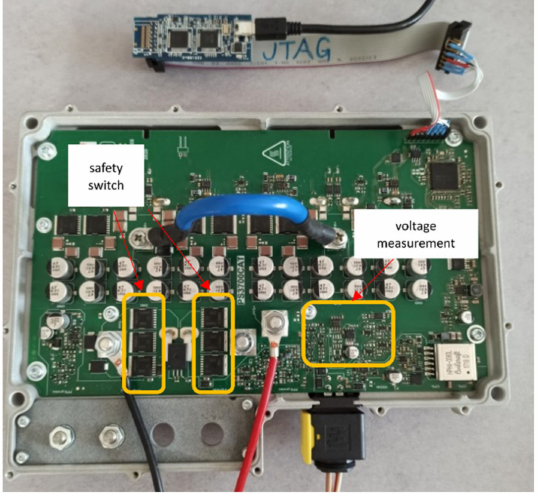
Figure 15. DC/DC converter prototype fitted with single-stage conditioning circuits. In Figure 16, experimental results for voltage error (labelled deltaU) on the full-scale range of measured input voltages from 0 V to U FS , ag = 3.3 V and 0 V to U FS , HP = 60 V are displayed for original (labelled u ag and u HP ) and reversed polarity labelled ( u ag , R and u HP , R ) for u gG = 0 V. Next, both circuits were exposed to a changing negative CMV ( u gG ) from 0 V to − 60 V, while preserving the measured voltages at their full-scale values of U FS , ag = 3.3 V and U FS , HP = 60 V. As expected from Figure 8, the circuit output voltage should remain constant (i.e., at 3.3 V) irrespective of the applied negative CMV, however, this is not entirely true as seen from Figure 17. Otherwise, if the difference amplifier circuit is not well balanced (i.e., R 1 (cid:54) = R 3 and/or R 2 (cid:54) = R 4 ), we could expect a significant discrepancy compared to balanced (ideal) values. For comparison, Figure 17 also shows the calculated worst-case voltage error margin vs. imposed negative CMV for resistances variation of ± 0.5% (labelled R 0.5% limit).